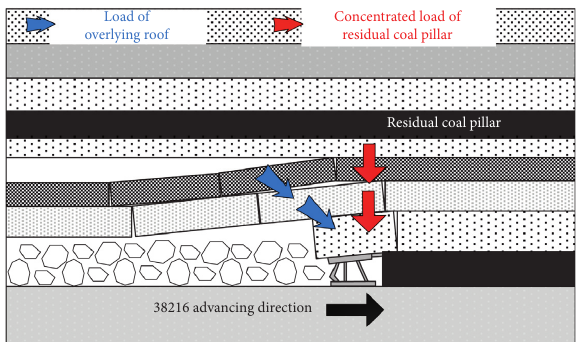
Figure 8: Structural model of the support bearing the load on the working face under a residual coal